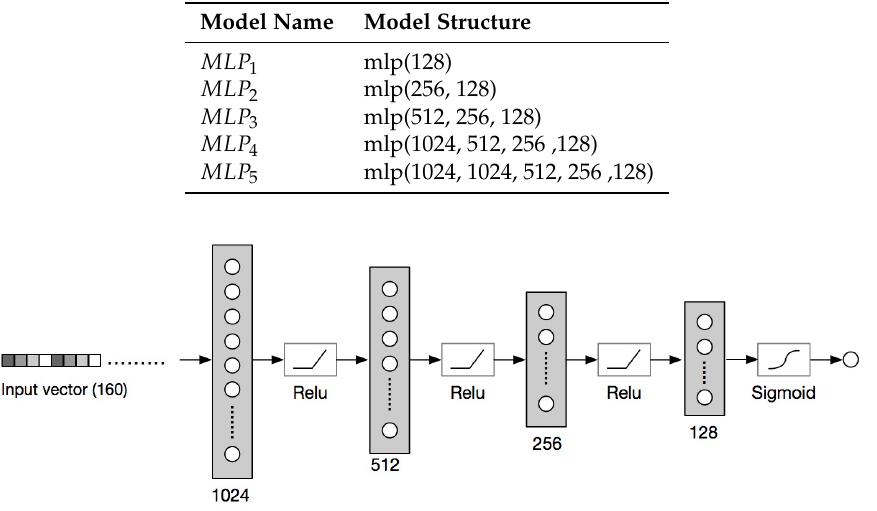
Table 1. Overview of the multi layer perceptron (MLP) architectures.